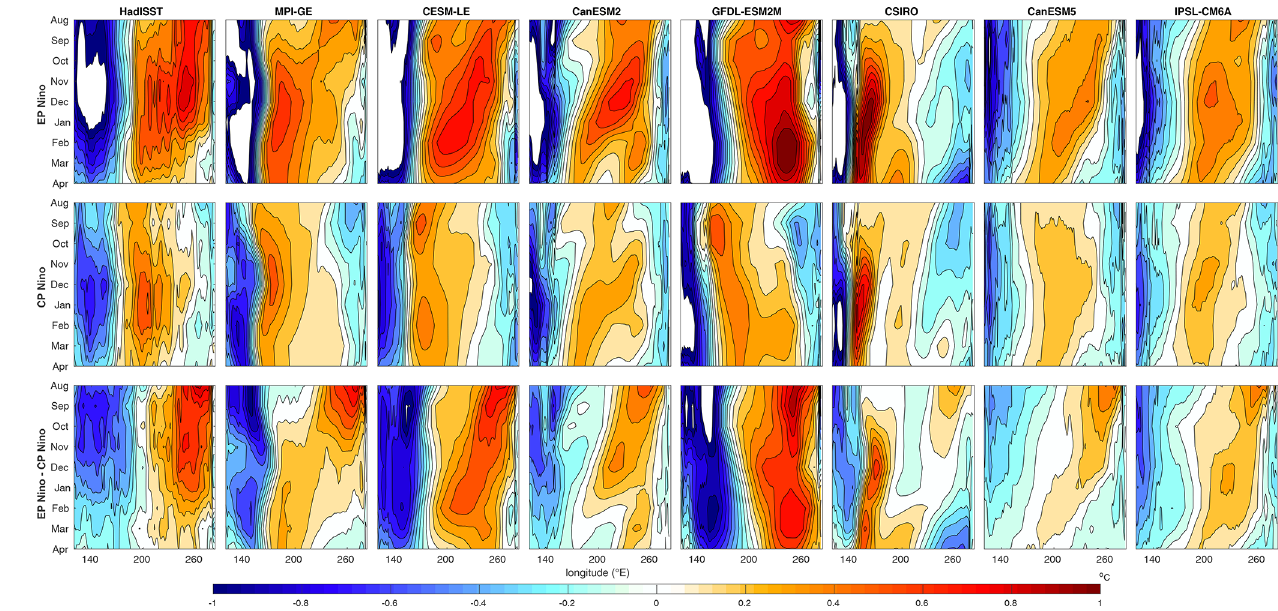
Figure 2. Hovmöller diagram of relative SST along the Equator in the Pacific Ocean for composites of EP and CP El Niño events and EP minus CP El Niño events (top, middle, and bottom row respectively); shown for HadISST observations (left column) and each individual SMILE (in order of appearance: MPI-GE, CESM-LE, CanESM2, GFDL-ESM2M, CSIRO, CanESM5, and IPSL-CM6A). SST is averaged between 5N and 5S and shown for August to April. SMILE data have the forced response (ensemble mean) removed before calculation, HadISST is detrended using a second-order polynomial, and then each month’s average is removed. The time period used is all of the historical period, which is shown for the observations in Table S1 and SMILEs in Table S2. Relative SST is calculated by removing the average SST between 120 and 280 ◦ E individually for each month. Table 4. Frequency of events (as a percentage) in the historical period for observations (HadISST) and the SMILEs, as well as the correlation between EP and CP patterns. The mean frequency and correlation across each ensemble is shown with the minimum and maximum values in brackets. The time period used is all of the historical period, which is shown for the observations in Table S1 and SMILEs in Table